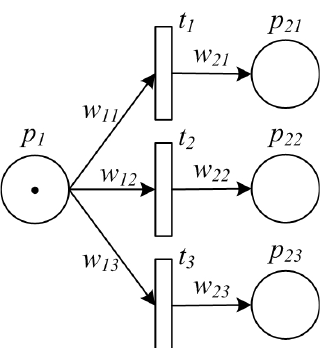
Figure 5. PPN model of exclusive choice